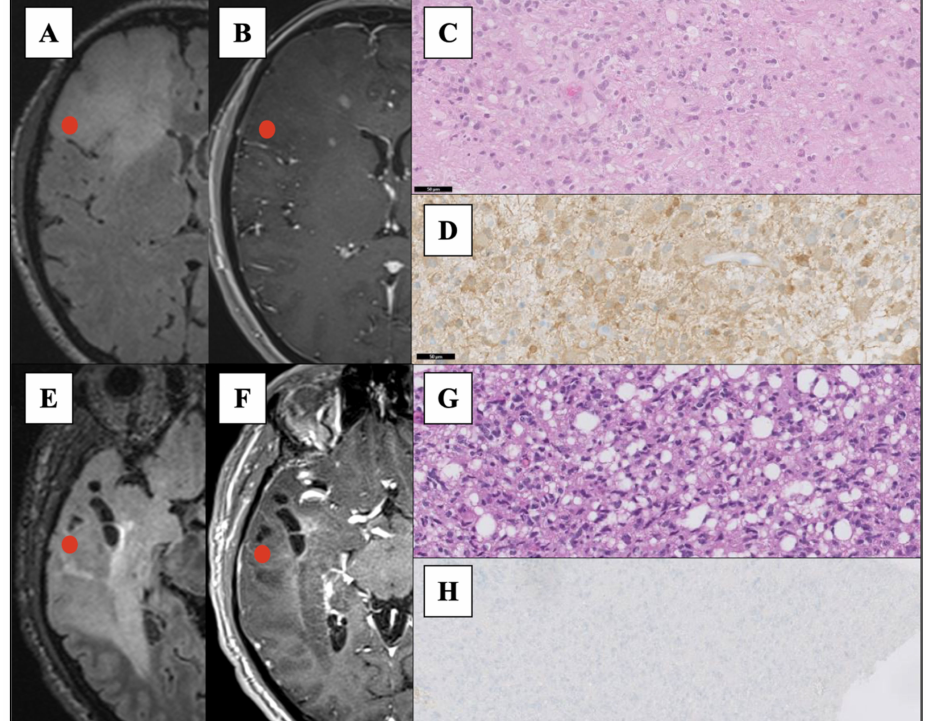
Figure 1. ( A , B ): Preoperative MRI (( A ) axial fluid-attenuated inversion recovery image and ( B ) T1 post-gadolinium axial scan) of a right frontal tumor consistent with Anaplastic Astrocytoma IDH-1 mutant, grade III (WHO 2016 [1]) after histological and molecular analysis. The red spots indicate the surgical location of the specimen labelled as IDH-MUT. ( C , D ) Histological evaluation of the sample analyzed after Raman analysis: panel ( C ) shows Hematoxylin-and eosin-stained section. (20 × magnification), panel ( D ) immunohistochemistry section stained using the diagnostic antibody to IDH1-R132H (20 × magnification). ( E , F ): Preoperative MRI (E, axial fluid attenuated inversion recovery image and F, T1 post-gadolinium axial scan) of a right temporal tumor consistent with Anaplastic Astrocytoma IDH-1 wild-type, grade III (WHO 2016). The red spots indicate the surgical location of the specimen labelled as IDH-WT. ( G , H ) Panel G shows Hematoxylin-and eosin-stained section (20 × magnification), and panel H shows the immunohistochemistry section stained using the diagnostic antibody to IDH1-R132H that resulted negative (10 × magnification). In both cases,